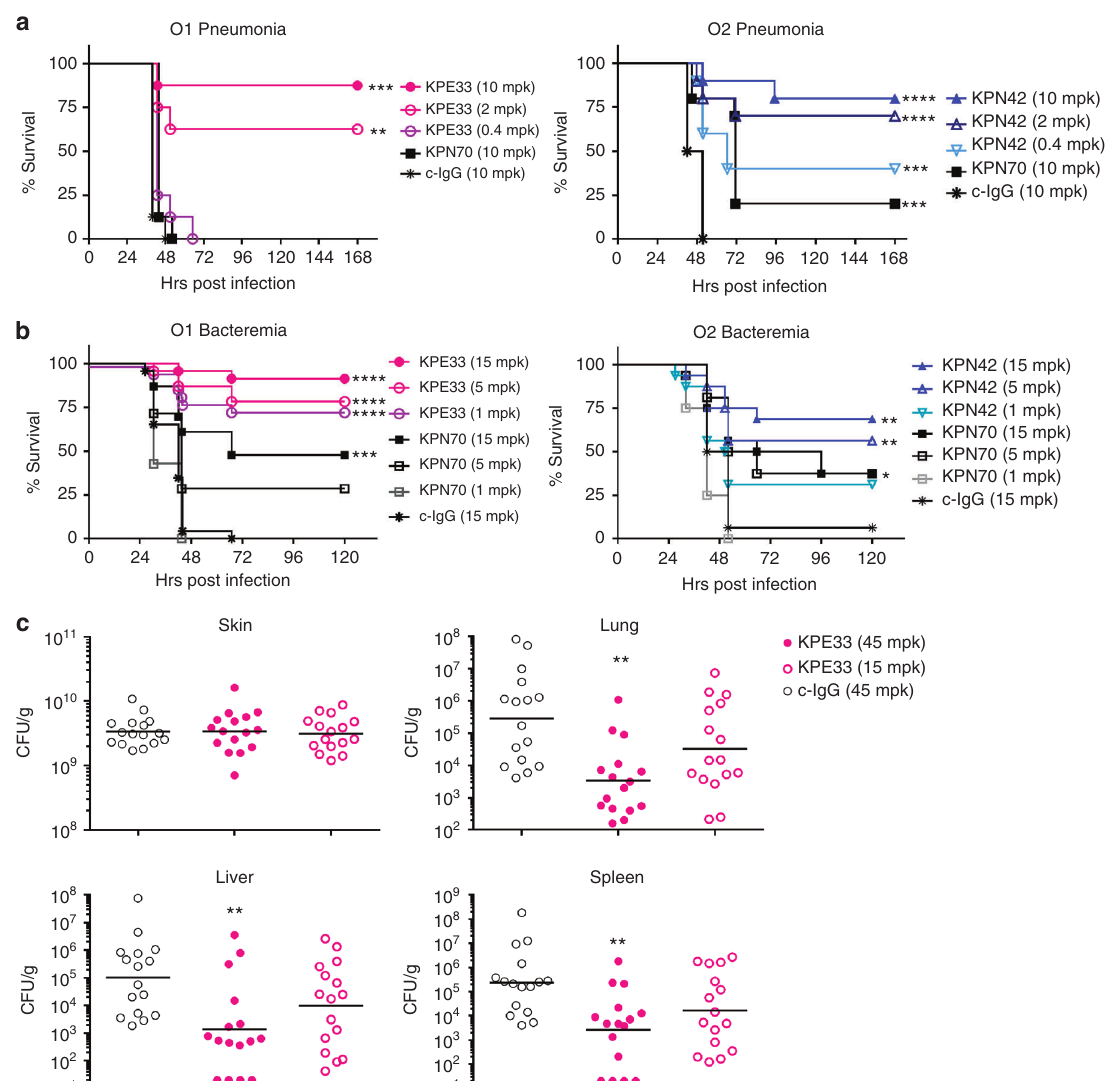
Fig. 5 Anti-O1 and anti-O2 mAbs are protective in vivo. a Therapeutic activity of the mAbs was tested in C57BL/6 mice infected intranasally with a K. pneumoniae O1 (Kp1131115, 6 × 10 7 CFU) or O2 (Kp961842, 2 × 10 8 CFU) strain. KPE33 (anti-O1), KPN42 (anti-O2) and KPN70 (anti-O1/O2) mAbs were administered intravascular 1 h post infection at the doses indicated. An isotype-matched mAb (c-IgG) was used as a negative control. b Prophylactic activity of the mAbs was tested in C57BL/6 mice infected intraperitoneal with the O1 strain Kp1131115 (3 × 10 6 CFU) or the O2 strain Kp961842 (1 × 10 7 CFU). mAbs were administered IP 24 h prior to infection at the doses indicated; survival was monitored for 5 days post infection. c CF1 mice received a dorsal burn followed by K. pneumoniae O1 (Kp1131115, 5 × 10 6 ) bacterial inoculation subcutaneously at the burn site. KPE33 (45 or 15 mpk) or isotype- matched control mAb (c-IgG, 45 mpk) were administered IP 24 h post infection, and organs were harvested 48 h post infection to determine bacterial CFU. All graphs are representative of at least three separate experiments. Mantel-Cox analysis was done to assess signi fi cant survival bene fi t compared to the control mAb. For thermal injury CFU comparison, Kruskal Wallace one way Anova analysis was done to compare differences in CFU between KPE33 treated vs. control IgG treated groups, **** p < 0.0001, *** p < 0.001, ** p < 0.01